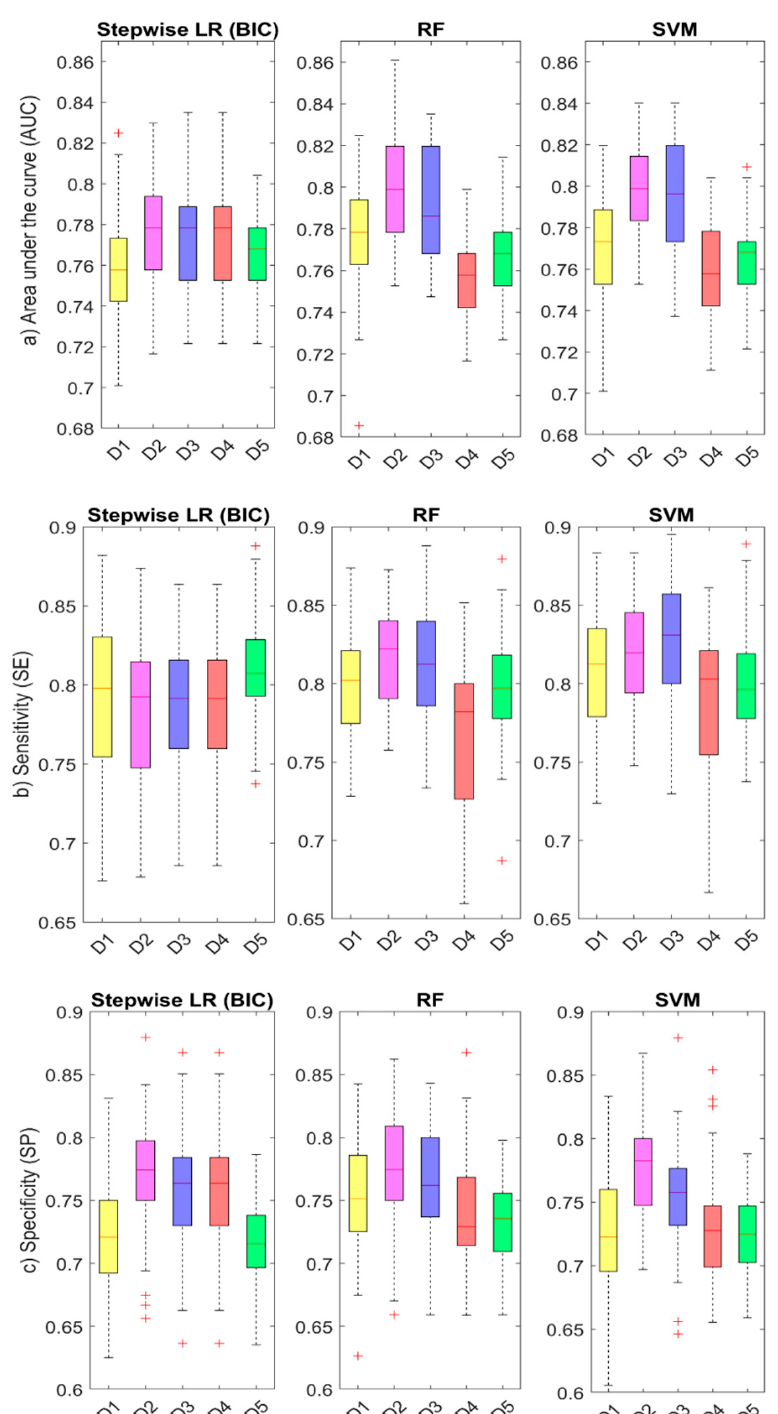
Figure 4. Comparison of accuracy for different predictor datasets and ML algorithms: the boxplots show the distribution of ( a ) AUC, ( b ) SE, and ( c ) SP parameters for different predictor datasets (D1–D5, see description in Table 4) and ML algorithms (LR, RF, and SVM). The red line represents the mean value (calculated over the 50-fold cross-validation estimates), and the edge boxes the 25th and 75th percentiles. The whiskers represent the minimum and maximum data values not considered outliers, and the outliers are plotted individually using the ‘+’ symbol in